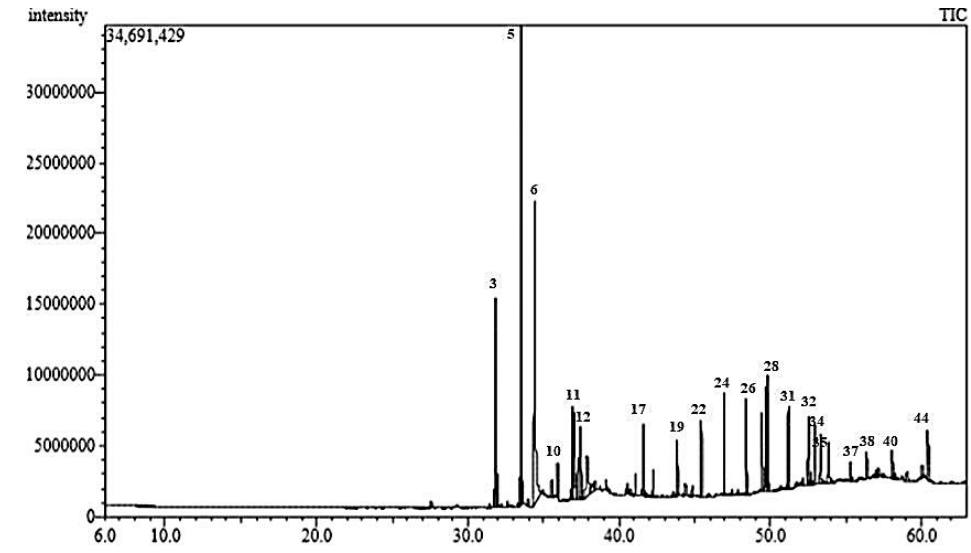
Figure 1. GLC-chromatogram of C. aethiopica L. n -hexane fraction (CAL-A) on Rtx-5MS column. Table 1. Chemical profile of C. aethiopica L. n -hexane fraction (CAL-A) by GLC-MS.